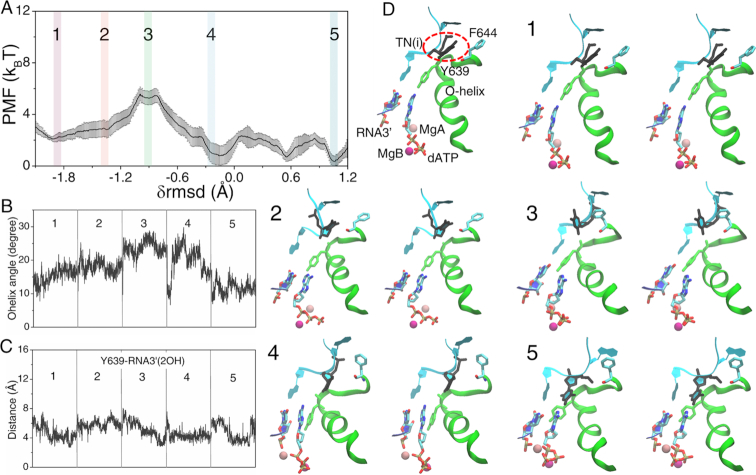
The constructed PMF of the non-cognate dATP bound structure from the pre-insertion off-path configuration to the semi-insertion state and key structure measures. (A) The PMF obtained from the umbrella sampling simulations along the collective reaction coordinate \documentclass[12pt]{minimal}
\usepackage{amsmath}
\usepackage{wasysym}
\usepackage{amsfonts}
\usepackage{amssymb}
\usepackage{amsbsy}
\usepackage{upgreek}
\usepackage{mathrsfs}
\setlength{\oddsidemargin}{-69pt}
\begin{document}
}{}${\rm{\delta rmsd}}$\end{document}. (B) The O-helix angle obtained from the five windows labeled on the PMF curve. (C) The distance between Y639 and RNA3′-2OH. (D) The five representative structures along the reaction coordinate (in stereo views). A pre-insertion configuration (config 1) with TN(i), Y639, O-helix, MgA/B, dATP, and RNA 3′ denoted is also shown. The red dashed circle highlights the significant shifting of the template TN(i) backward.